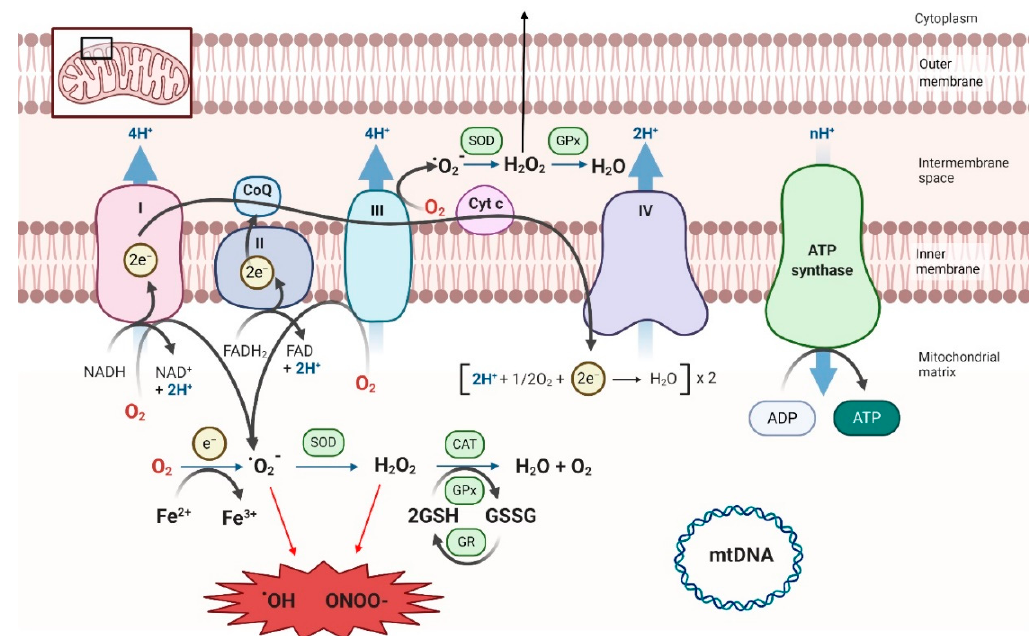
Figure 2. Main sources of mitochondrial reactive oxygen species (ROS). Mitochondrial respiratory chain (MRC) is composed of four enzyme complexes (I–IV). Electrons donated from NADH and FADH 2 in the Krebs cycle are transferred at complex I and II respectively, and consecutively to complex III and IV. This electrons transfer is coupled with protons transport across the inner membrane, generating a proton-gradient, allowing ADP phosphorylation through ATP synthase (complex V). Oxygen metabolism generates superoxide anion ( · 0 2 − ), which in turn is conversed into hydrogen peroxide (H 2 O 2 ) by SOD (superoxide dismutase) and then converted into water thanks to the action of some of the antioxidant enzymatic defenses such as catalase (CAT) or the glutathione peroxidase (GPx) reductase (GPr) system. Excessive ROS production can oxidize proteins, lipids, or mitochondrial DNA (mtDNA), eventually leading to mitochondrial dysfunction and cell death.